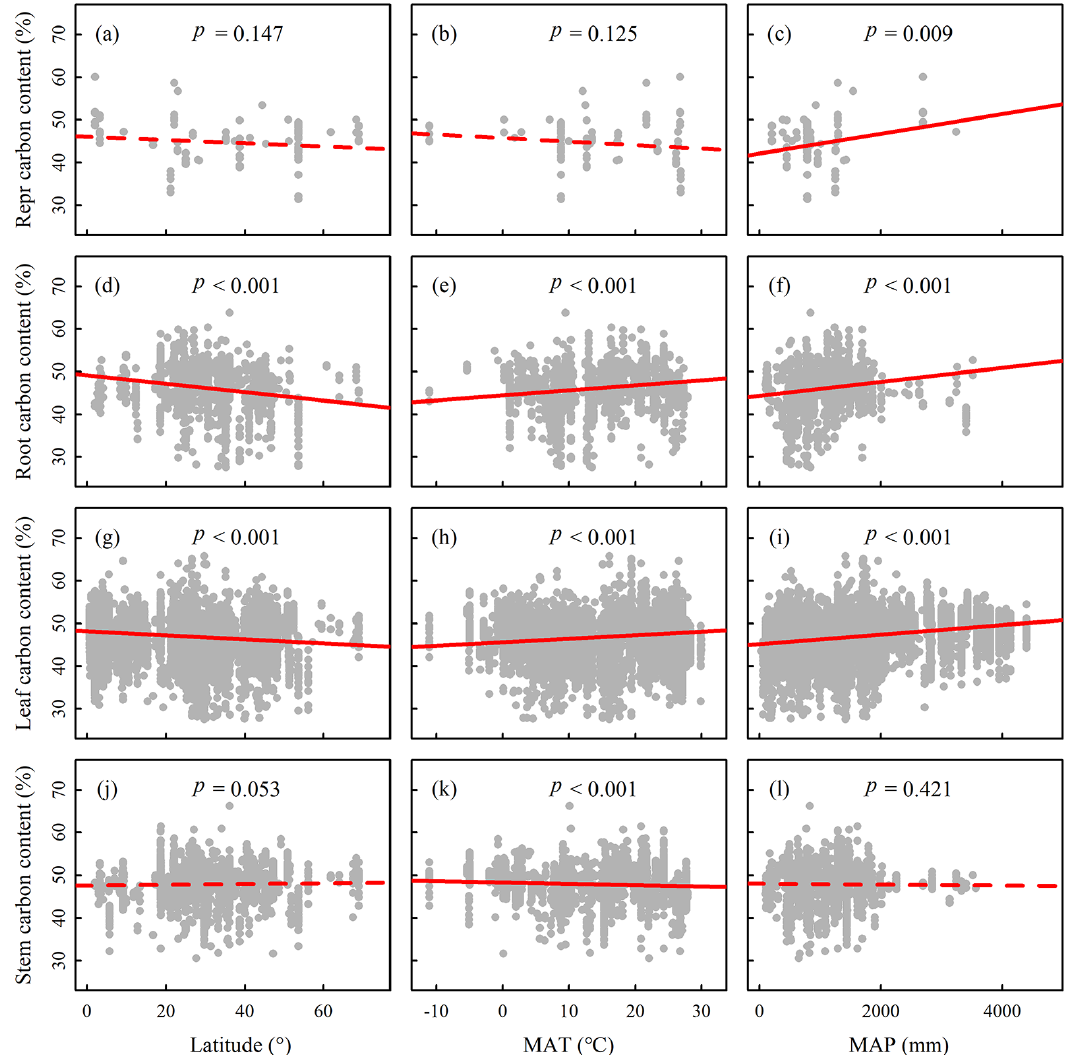
Figure 3. Trends in the plant carbon contents along latitude and climate gradients. MAT, mean annual temperature; MAP, mean annual precipitation. Ordinary least squares (OLS) regression lines are fit to the data. Solid lines indicate the significant relationships with p <0.05, and dashed lines denote the insignificant relationships with p >0.05. Abbreviations: repr carbon content refers to the reproductive organ carbon content. Plant carbon content in roots and leaves showed a significant latitudinal